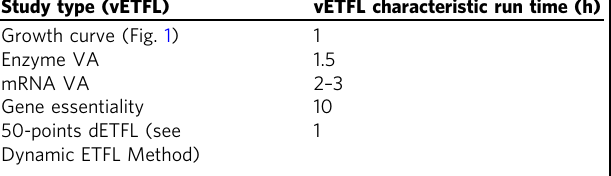
Table 4 Characteristic completion run times for several types of studies in the vETFL study of